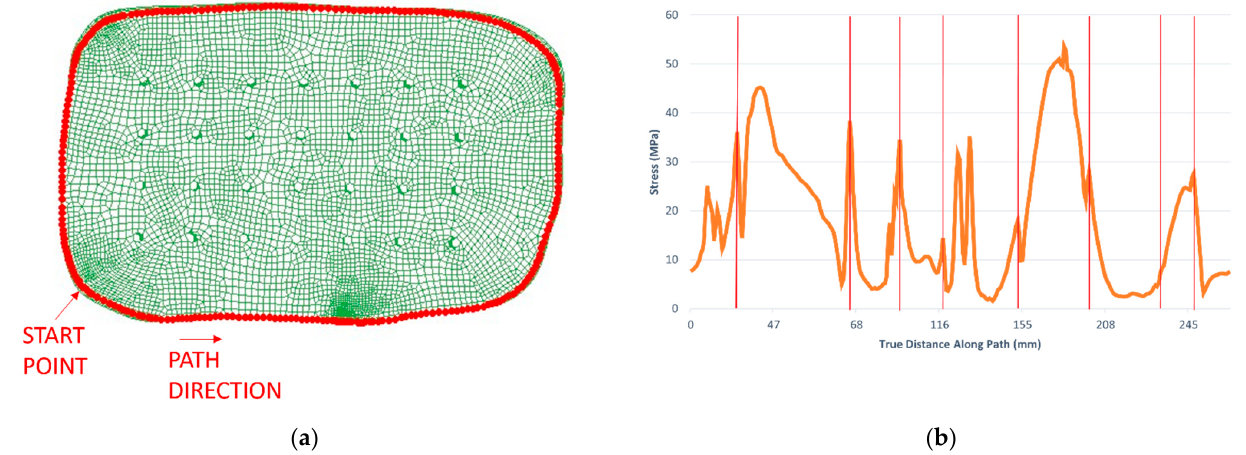
Figure 7. Analysis of the stress evolution along with the interface between skull and implant: ( a ) path along with the interface between skull and implant; ( b ) von Mises stress evolution along the path, with the locations of the screws highlighted by the red bars.